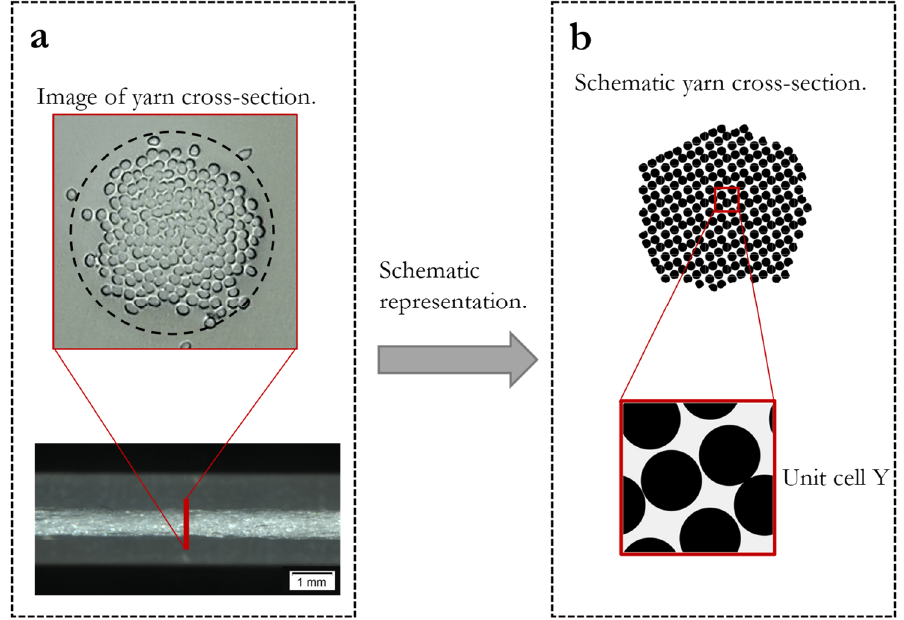
Figure 2. ( a ) Image of a melt spun multifiber polyester yarn and visualization of a cross-section of yarn by embedding in resin. ( b ) Schematic representation of yarn cross-section with corresponding RVE Y.